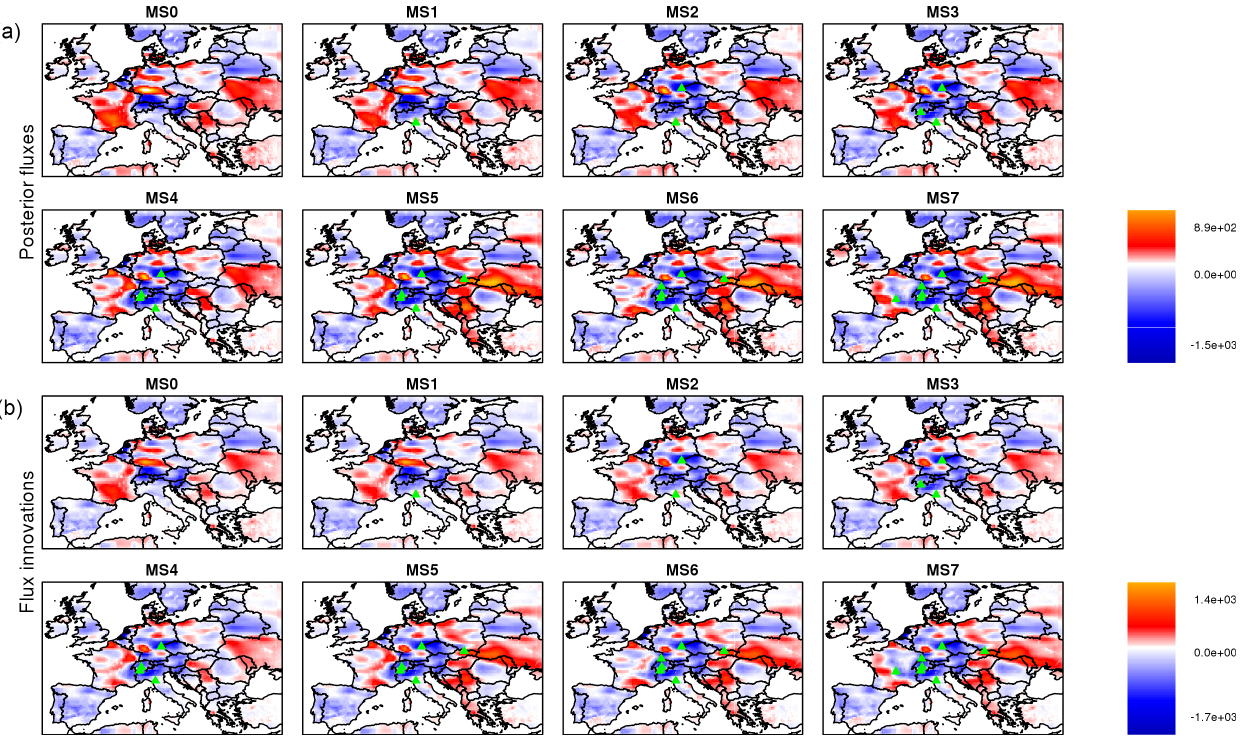
Figure 4. As Fig. 3, but only for the nBB inversion case. The numbers denote the number of mountain sites used in the inversions, e.g., MS0: no mountain site. Units are in gCyr − 1 m − 2